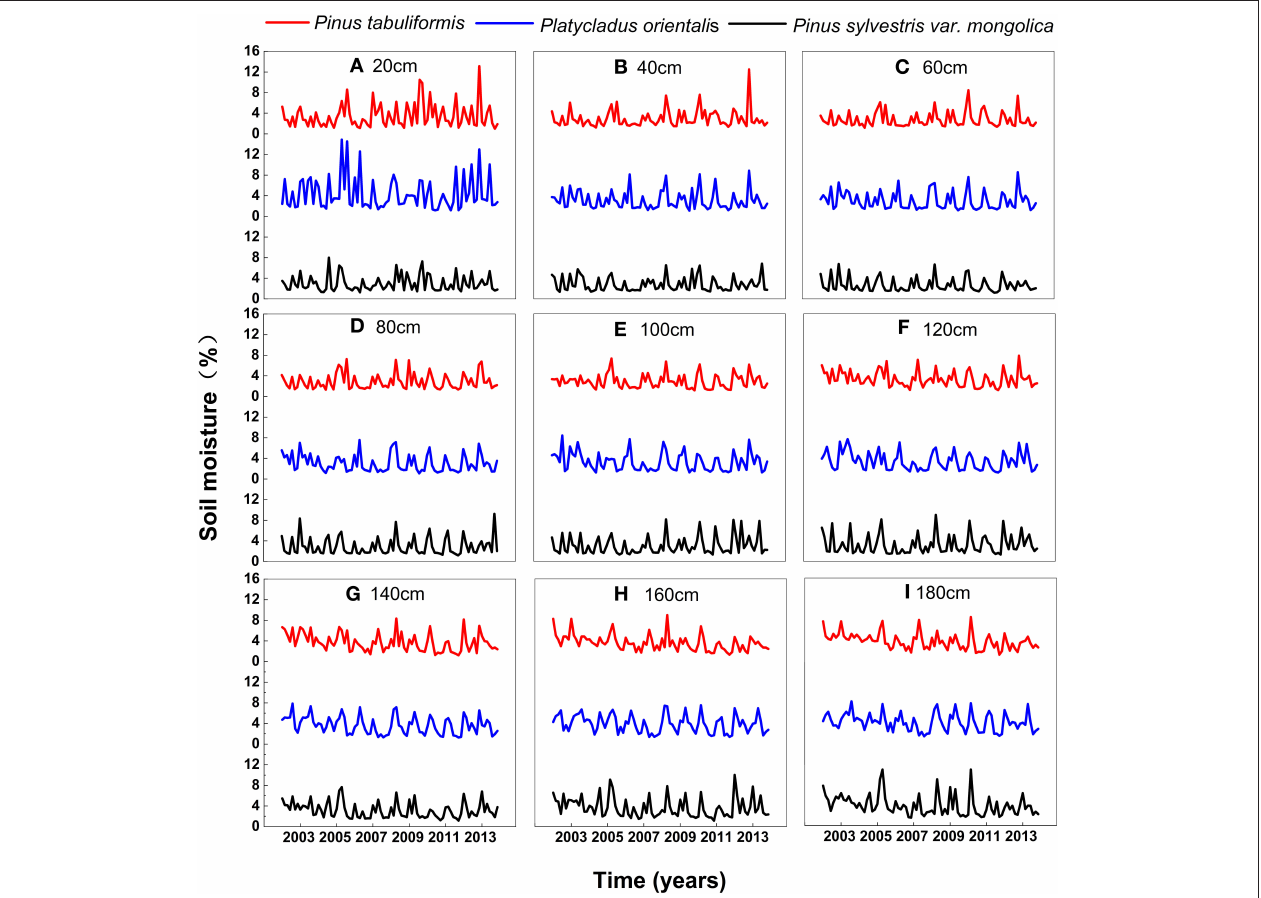
FIGURE 3 | The dynamics of soil water content of different soil layers at (A) 20cm, (B) 40cm, (C) 60cm, (D) 80cm, (E) 100cm, (F) 120cm, (G) 140cm, (H) 160cm, and (I) 180cm in woodland.